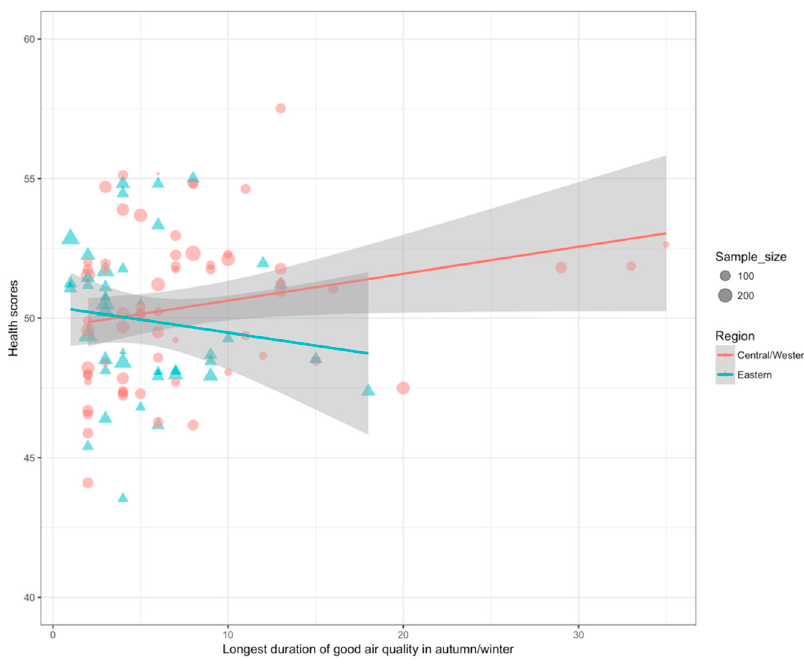
Figure 2. Correlation between health scores and longest duration of good air quality in autumn/winter in Central/Western China, stratified by region. (Solid lines indicate the fitted linear regression, and the grey regions indicate 95% confidence intervals. The dots represent cities in Central/Western China, and the triangles represent cities in Eastern China. The sizes of the dots and triangles represent sample size).